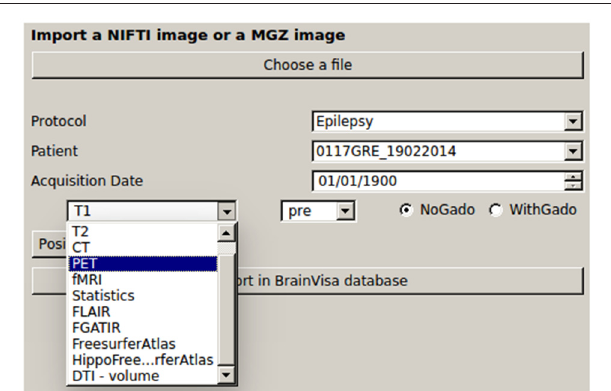
FIGURE 2 | GUI for importing the data in IntrAnat Electrodes. BrainVisa database is organized in terms of Protocol, Patient code and acquisition date. The left panel shows the possible classes of imported images, which can be specified as “pre,” “post,” and “postop” according to the (stereoelectroencephalography, SEEG) protocol. On the right-hand side, it is possible to specify whether images where obtained with or without injection of Gadolinium, in order to improve the results of subsequent segmentation routines.